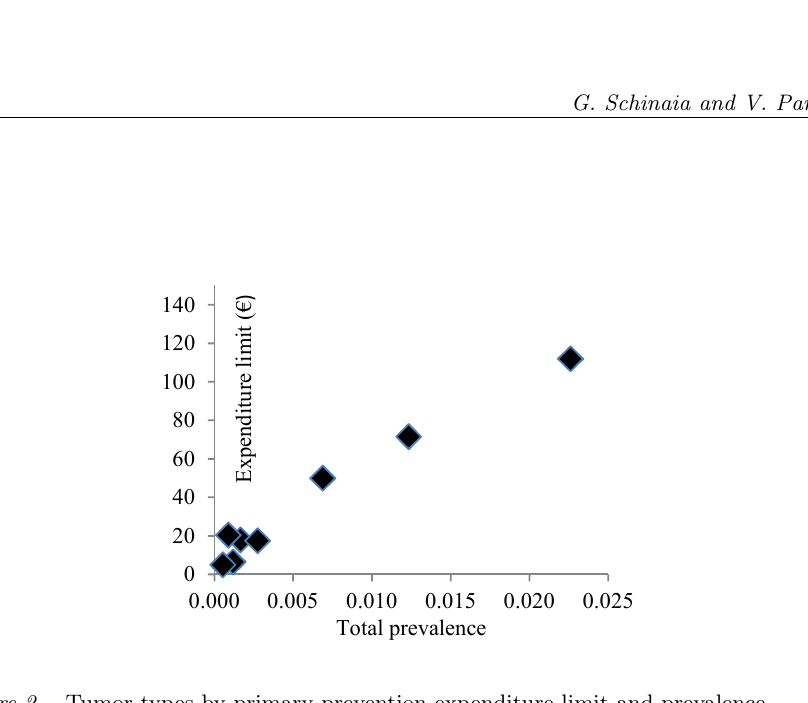
Figure 2 { Tumor types by primary prevention expenditure limit and prevalence.